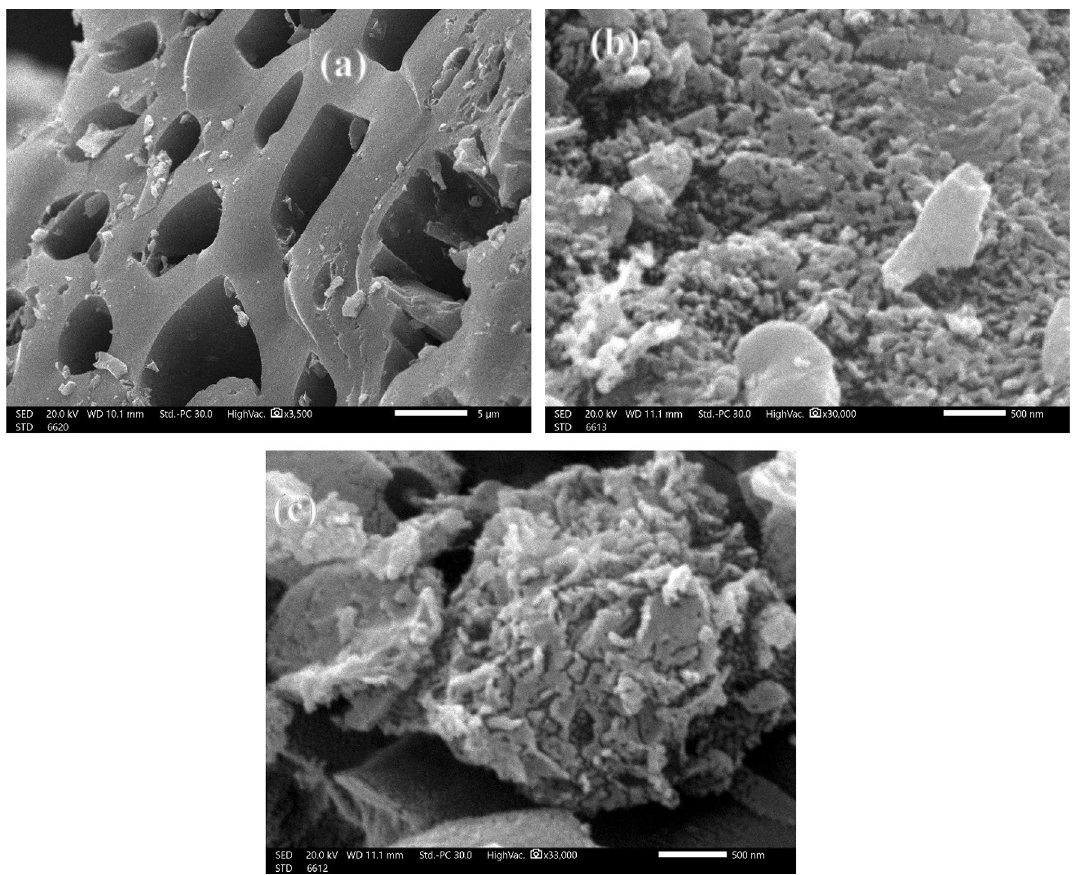
Figure 3. SEM picture of PPAC at ( a ) PPAC at 600 °C, ( b ) PPAC at 700 °C, ( c ) PPAC at 800